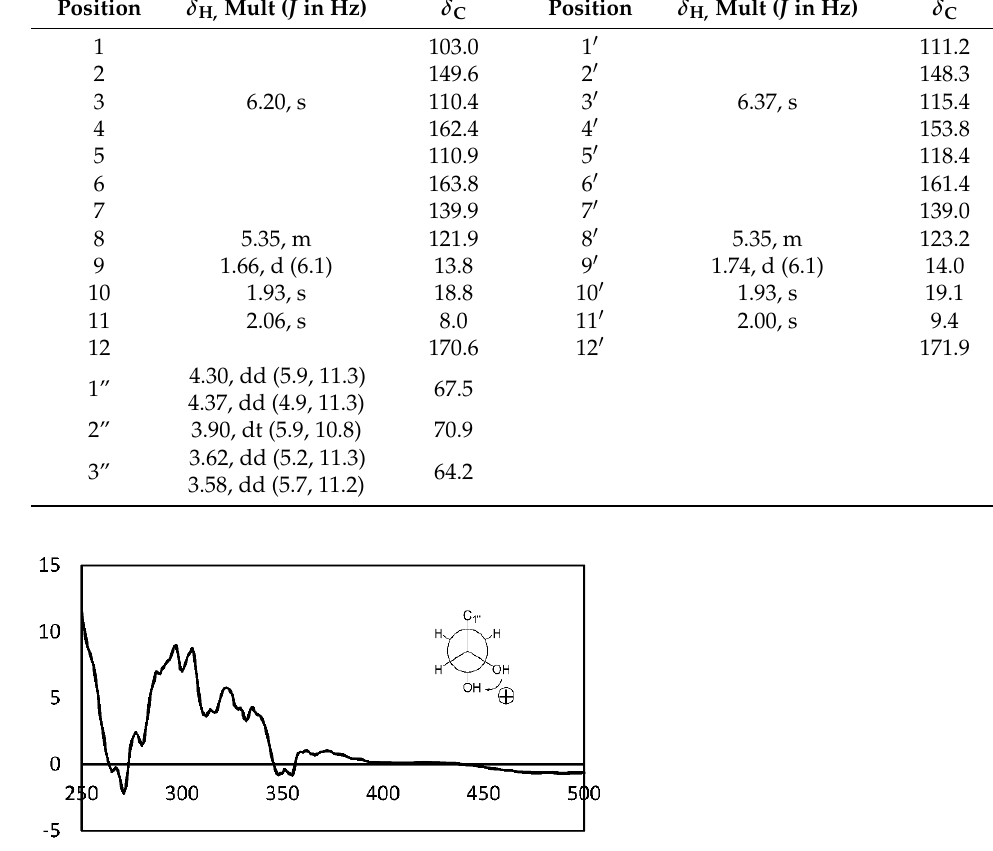
Figure 3 . ICD spectrum of 12 . Figure 3. ICD spectrum of 12 Table 2. 1 H and 13 C NMR data of 12 in CD 3 OD (600 MHz for 1 H and 150 MHz for 13 C).